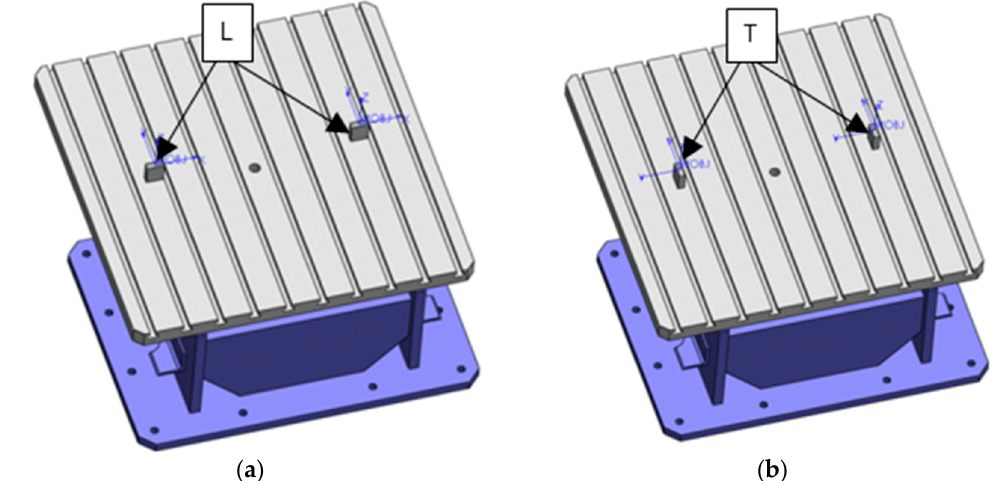
Figure 4. ( a ) Orientation of the workpiece in L direction; ( b ) orientation of the workpiece in T direction.